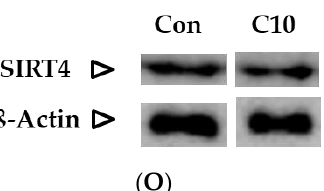
Figure 4. Graphs ( A – C ) represent absolute SIRT 1–3 enzyme activity., ( D – F ) and M represent relative protein expression and ( J – L ) and N represent relative gene expression of SIRT 1–4. ( G – I ) and O are representative western blot images. * p < 0.05 ( n = 3–6). Data are represented as mean + SD.